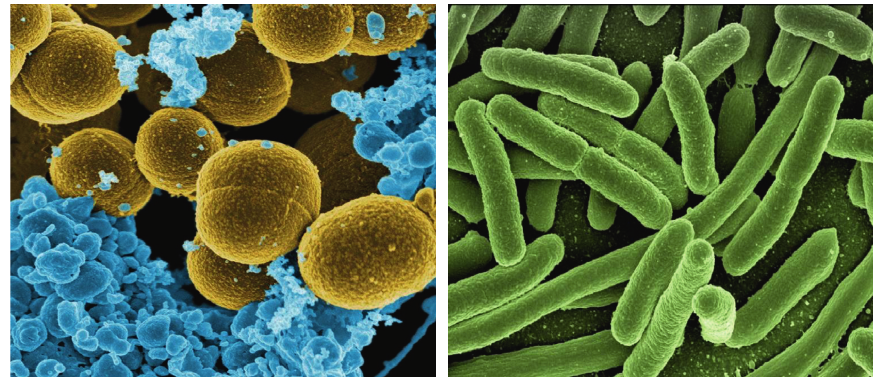
Figure 1: Staphylococcus aureus and Escherichia coli (http://alturl.com/uc3j5 and